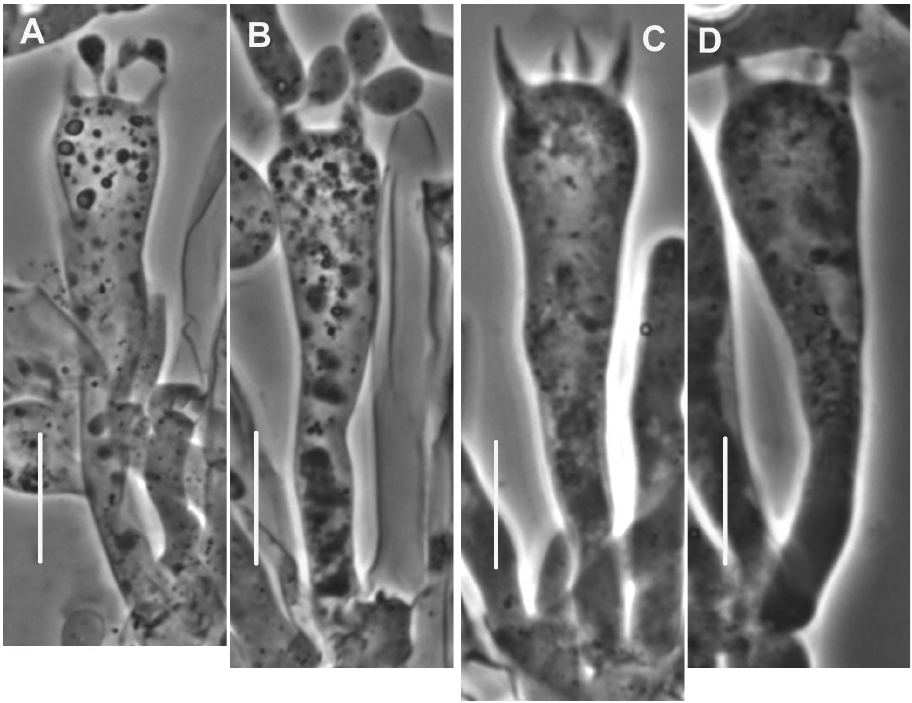
Figure 82. Mycetinis scorodonius f. diminutivus . Basidia. Standard bars = 10 µm. WTU 19061-10-20-2015.